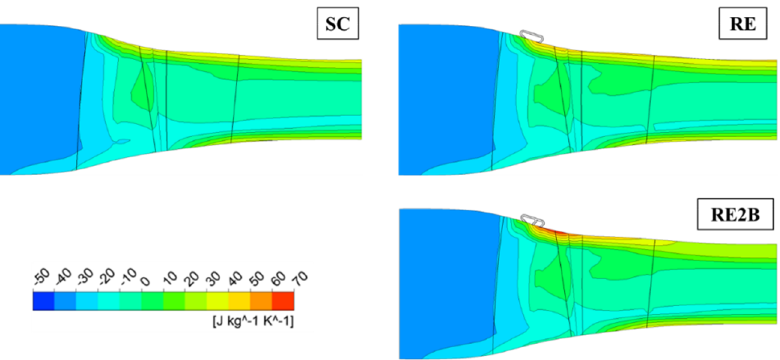
Figure 9. Circumferential-averaged static entropy contours at peak adiabatic efficiency condition.